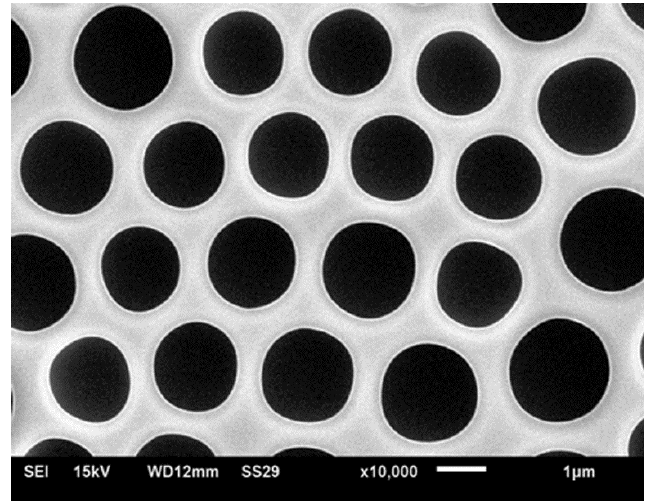
Figure 2. Typical honeycomb pattern arising from breath-figure self-assembly. The pattern was obtained by dip-coating the polyethylene substrate with the solution, containing 5 wt % of polycarbonate and a mixture of chlorinated solvents, namely: dichloromethane CH 2 Cl 2 (90 wt %)/chloroform CHCl 3 (5 wt %).